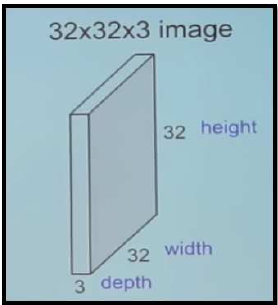
Figure 2. Convolution of multi-channeled